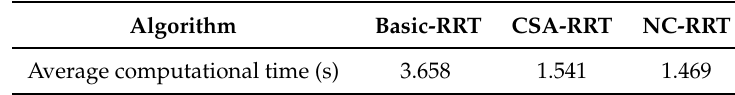
Figure 8. Simulation of a 6-DOF manipulator. The three algorithms are separately applied to the manipulator to allow it to pass through a tunnel and reach the target configuration. Table 4. Average computational time for each algorithm applied to the 6-DOF manipulator (10% goal bias, 100% success